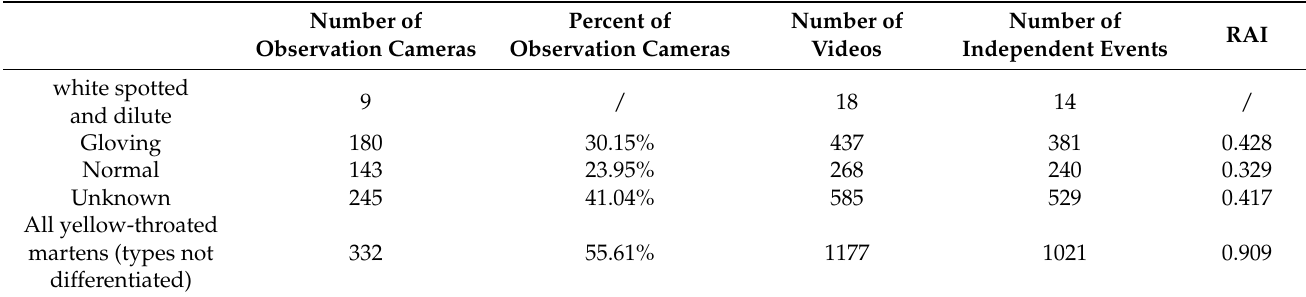
Table 2. Comparison of different types of martens from 1 January 2014 to 31 December